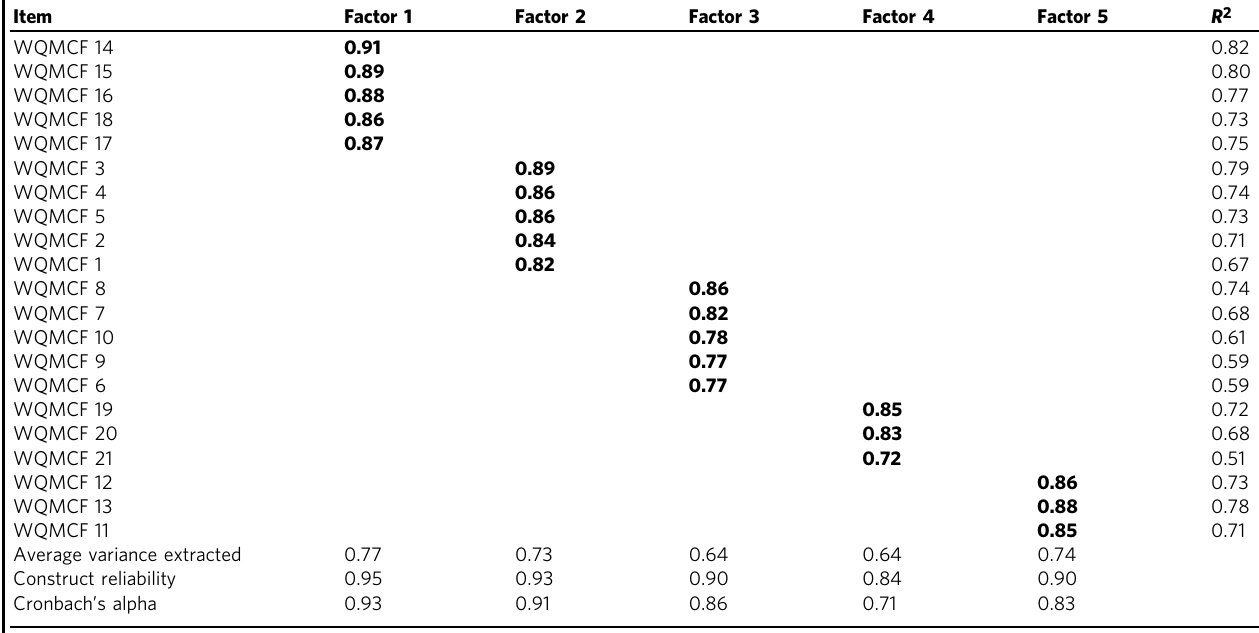
Table 7 Standardized factor loadings, R 2 , variance extracted and reliability estimates for the hypothesized fi ve-factor model (21